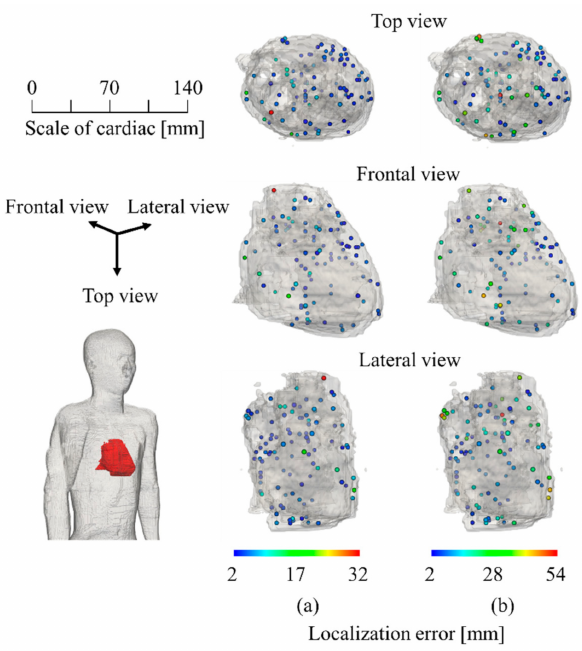
Figure 6. Visualized LE for each of 100 test dipoles: ( a ) homogeneous and ( b ) inhomogeneous.